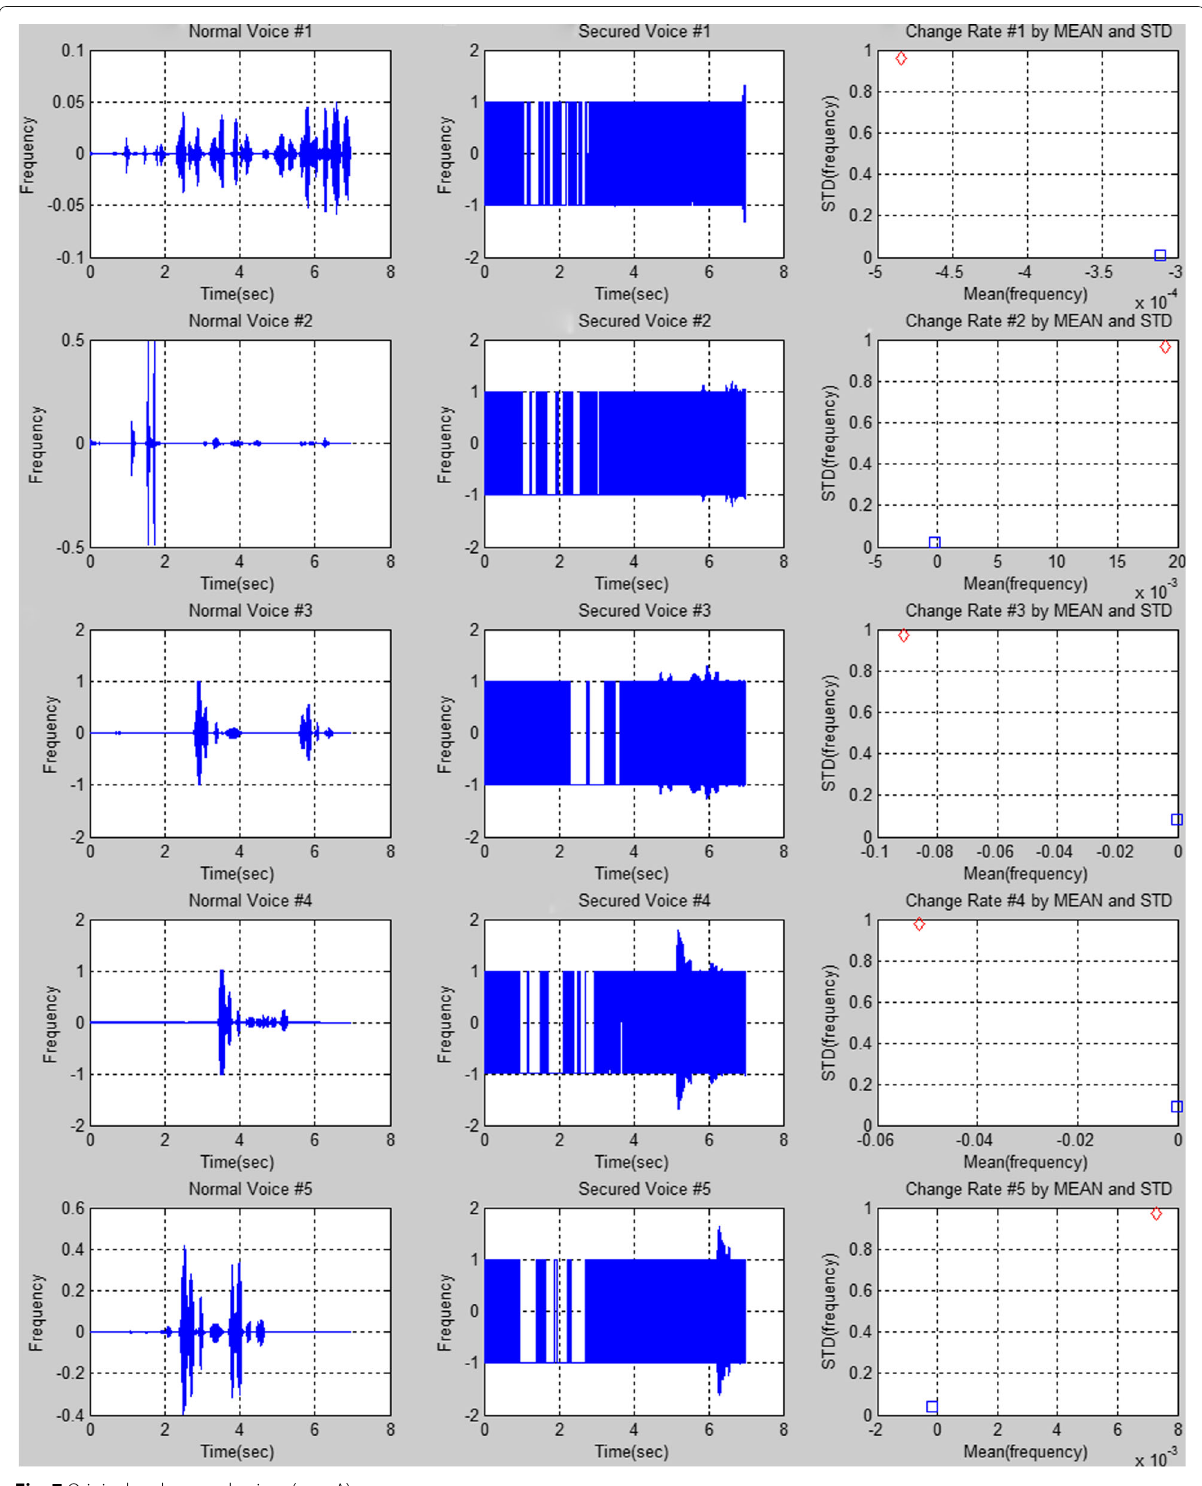
Fig. 7 Original and secured voices (user